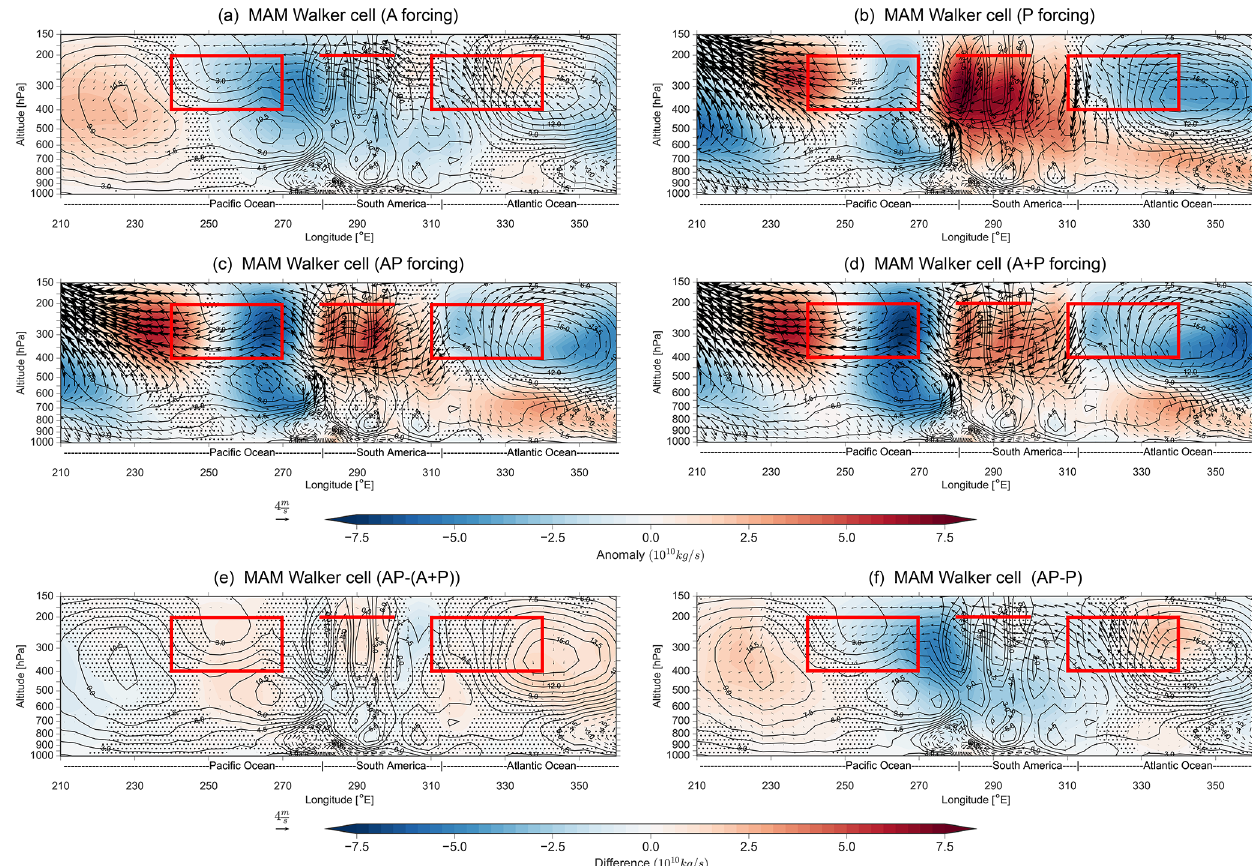
Figure 4. MAM Walker cell analysis for the region connecting the Pacific and the Atlantic, averaged between 5 ◦ S and 5 ◦ N. Shading represents the streamfunction ( ψ ), contours represent the streamfunction climatology (in intervals of 1 . 5 × 10 10 kgs − 1 ), and vectors represent the zonal winds ( u ) and vertical velocity ( w ) response to the different forcings from the Atlantic (a) , Pacific (b) , and Atlantic plus Pacific combined (c) , as well as the linear addition of the Pacific and Atlantic contributions (d) . The contours represent the model climatology. The difference between the linearly combined response (A + P) and the combined response (AP simultaneously) is represented in panel (e) , while the Atlantic contribution (f) is derived as the difference between ( c , AP forcing) and ( b , P forcing). Stippling in panels (a) – (c) represents anomalies that are not statistically significantly different from climatology at the 95% level using a two-tailed Monte Carlo test. Stippling in panel (e) represents differences that are not statistically significantly different between the AP forcing (c) run and the linear combination of the Atlantic and Pacific (A + P, d ) at the 95% level using a two-tailed Monte Carlo test. Stippling in panel (f) represents differences that are not statistically significantly different from the P forcing run at the 95% level using a two-tailed Monte Carlo test. The rectangular boxes represent the areas for computing the Walker index, while the horizontal line represents level and longitude for RWS index. Wind vectors in (e) and (f) represent statistically different winds from (A + P) and (P),